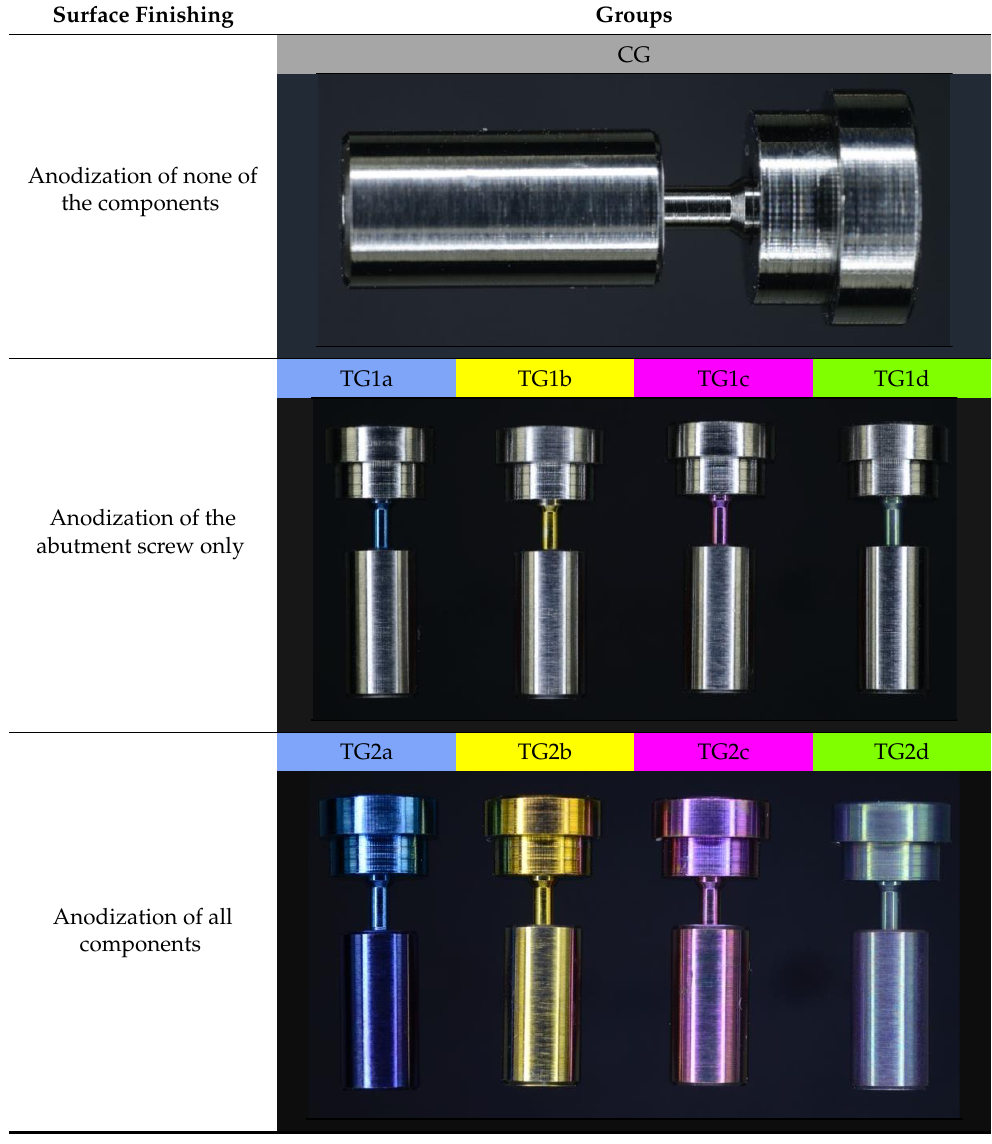
Table 1. Anodization and anodization stage of the components.